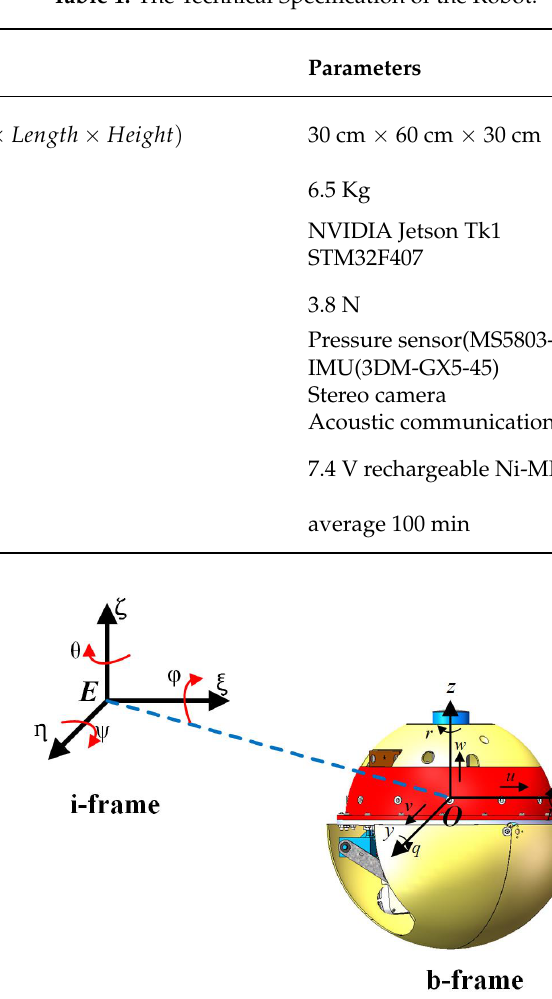
Table 1. The Technical Specification of the Robot.